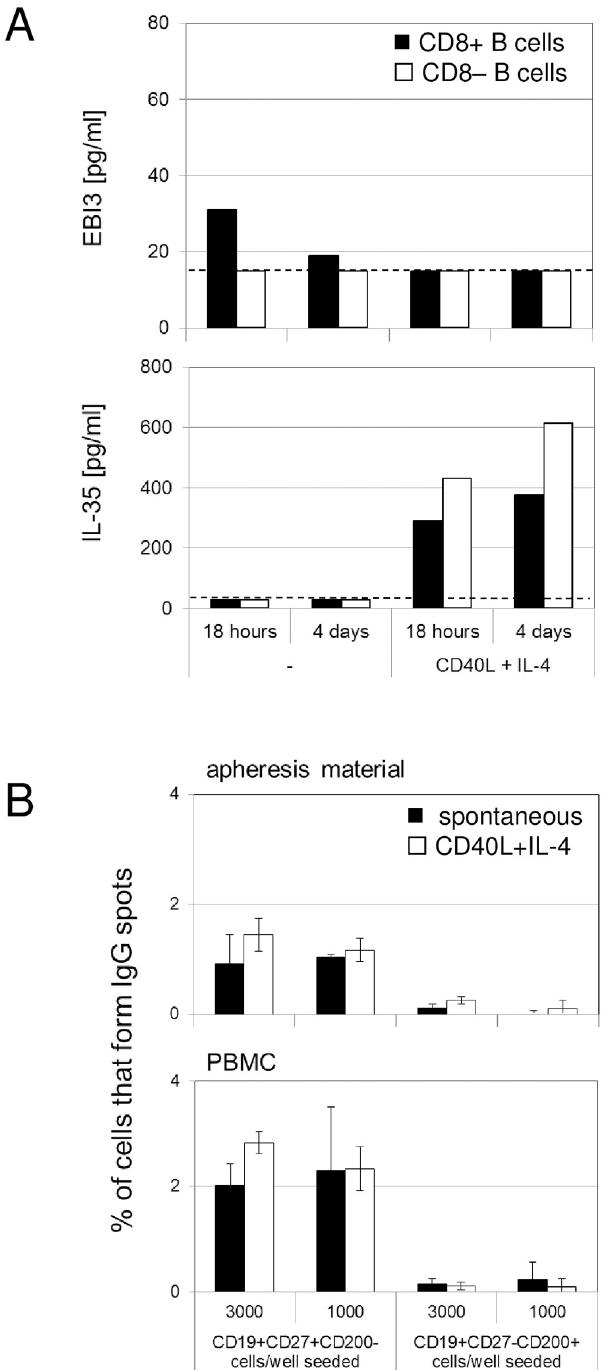
Fig 5. CD8 positive B cells release cytokines and immunoglobulins. (A) Production of the cytokines EBI3 and IL-35 was determined by ELISA from supernatants of freshly sorted CD8+ B cells (black bars) and CD8- control B cells (white bars). Cultures contained 50’000 cells in 200 μ l volume. As indicated, samples for both measurements were obtained at 18h and 4 days, without or with CD40+IL-4 stimulation. The dashed line indicates the assay detection limit. (B) Production of IgG was determined by ELISPOT using cells sorted either from apheresis material or from peripheral blood (PBMC). Spots were counted, and are expressed as percentage of input cells (3’000 or 1’000 cells per well, as indicated). Cultures were performed without (black bars) or with CD40L+IL-4 stimulation (white bars).